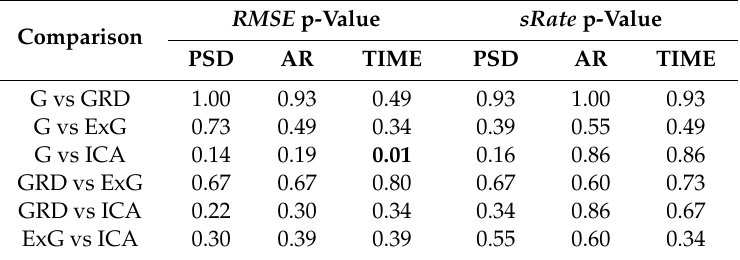
Table A6. The Wilcoxon rank sum test results (p-values) for comparing di ff erent signal extraction methods.